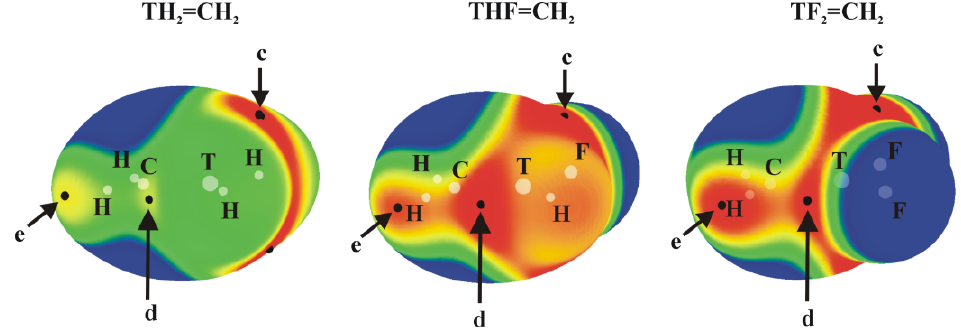
Figure 1. MEPs of TH 4 , TH 3 F and TH 2 F 2 (T = Si, Ge or Sn) computed on the 0.001 au isodensity surface at the MP2/aug-cc-pVDZ-PP level. Colour ranges, in kcal/mol, are: red greater than 15, yellow between 8 and 15, green between 0 and 8, blue below 0 kcal/mol. The letters a and b mean different types of V s,max.